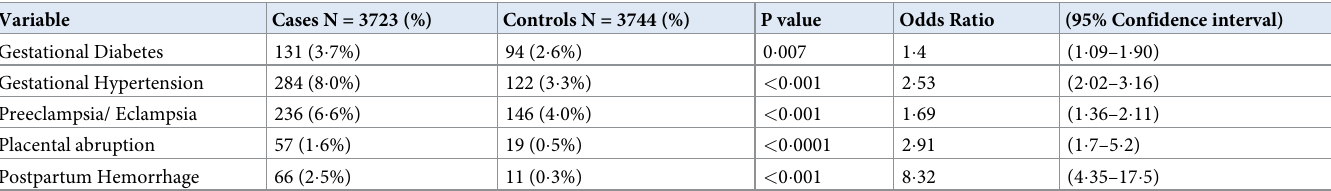
Table 4. Pregnancy-related complications among cases vs controls.